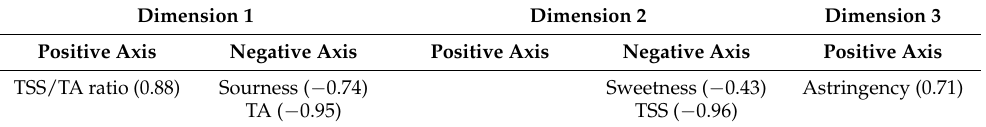
Table 5. Correlation coefficient ( r > 0.5) between the taste descriptors and the first three dimensions. Dimension